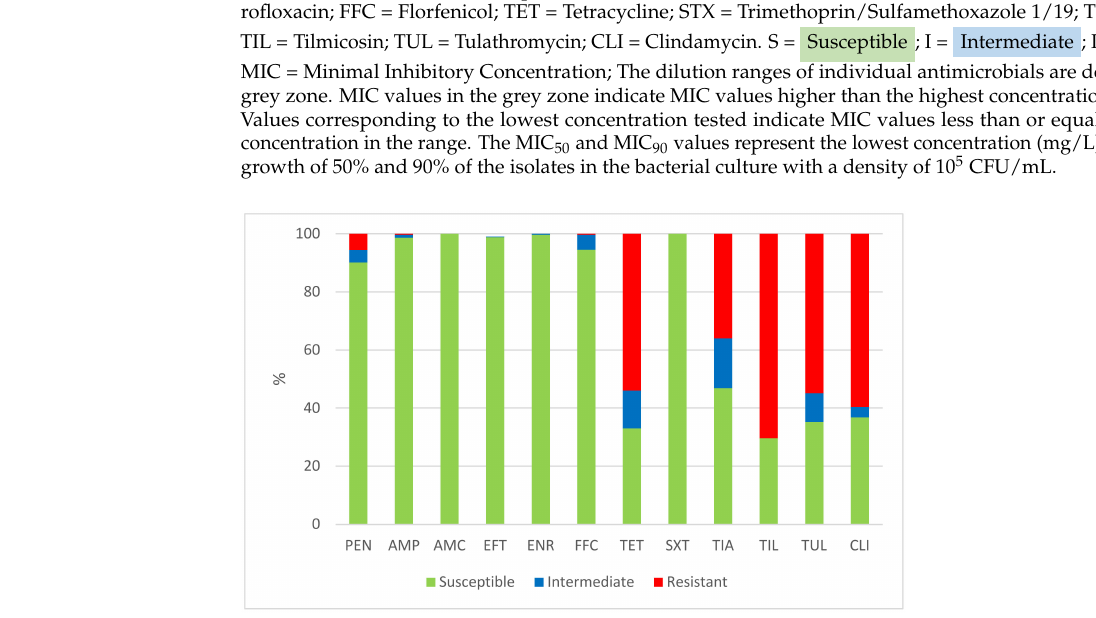
Figure 2. The percentage of susceptible, intermediately resistant, and resistant S. suis isolates from Czech farms in 2018–2022 ( n = 506). PEN = Penicillin; AMP = Ampicillin; AMC = Amoxi- cillin/Clavulanate 2/1; EFT = Ceftiofur; ENR = Enrofloxacin; FFC = Florfenicol; TET = Tetracycline; STX = Trimethoprin/Sulfamethoxazole 1/19; TIA = Tiamulin; TIL = Tilmicosin; TUL = Tulathromycin; CLI =